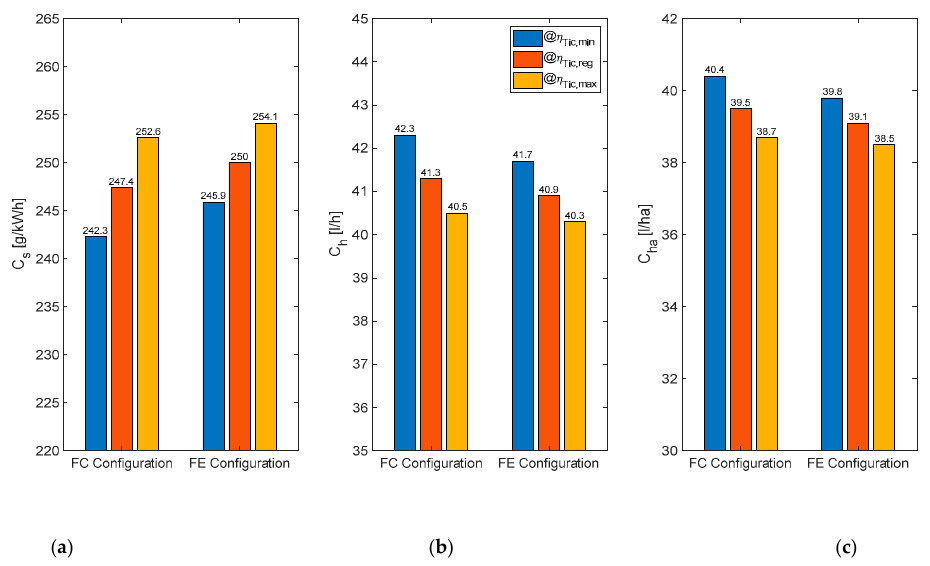
Figure 10. Predicted values of ( a ) C s , ( b ) C h and ( c ) C ha , for tractor configurations FE and FC in 8th gear. For each configuration, the blue, orange and yellow bars refer to estimations determined using, respectively, the lower prediction bound of the model, the regression model R3, and the upper prediction bound of the model.